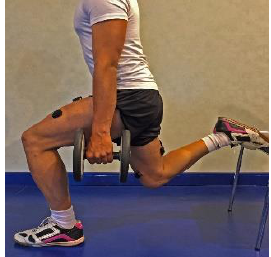
Figure 2. Bulgarian squat exercise.